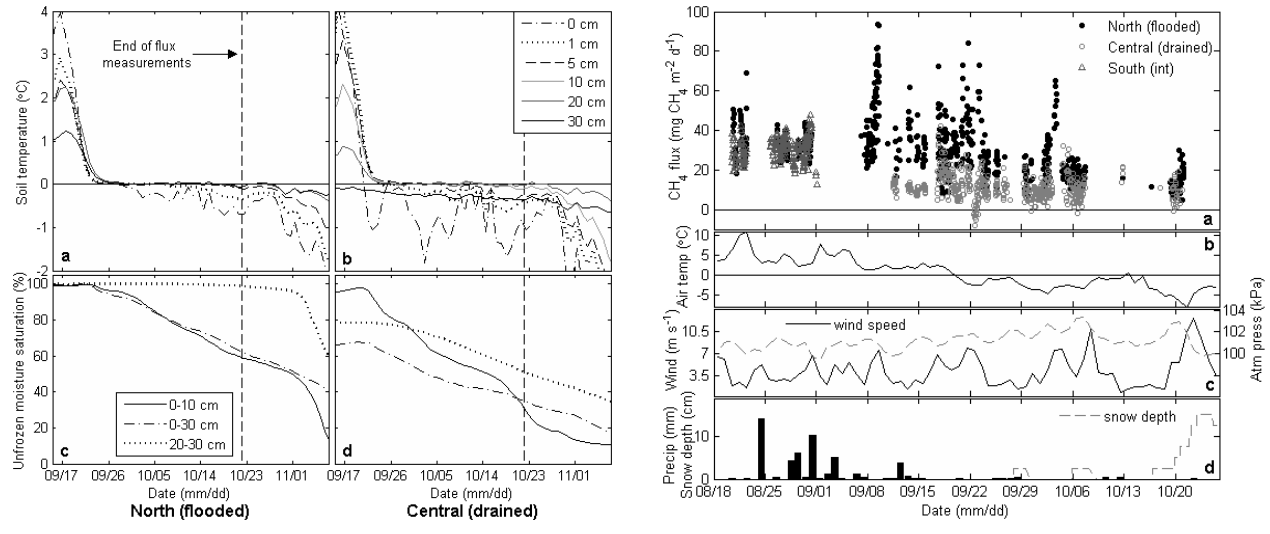
Figure 4. Top: Soil temperature profiles (a and b) and unfrozen moisture saturations (c and d) in the North (flooded; left column) and Central (drained; right column) sections during the period of soil freeze. Note that the soil temperature sensor at 10 cm depth in the North section was non-functional during this time. The vertical dotted line indicates the date of last non-rejected flux measurements.